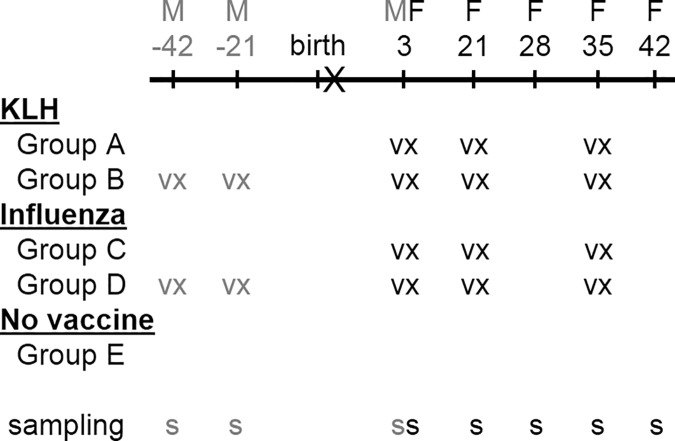
Neonatal vaccination and sampling protocols.Timeline diagram in days describing the vaccination (vx) and sampling (s) schedule for each group. Pregnant mares (M, gray text) were vaccinated on days minus 42 and minus 21, approximately, before foaling with keyhole limpet hemocyanin protein (KLH, Group B) or a commercial influenza vaccine (Group D). Foals (F, black text) were vaccinated on days 3, 21 and 35 of age with KLH protein (Groups A and B) or influenza vaccine (Groups C and D). Blood samples for serum and antigen-specific B cell sorting were collected on days 3, 21, 28, 35 and 42 days of age prior to vaccination. The protocol included a control group (Group E) of non-vaccinated mares and foals with the same sampling times.